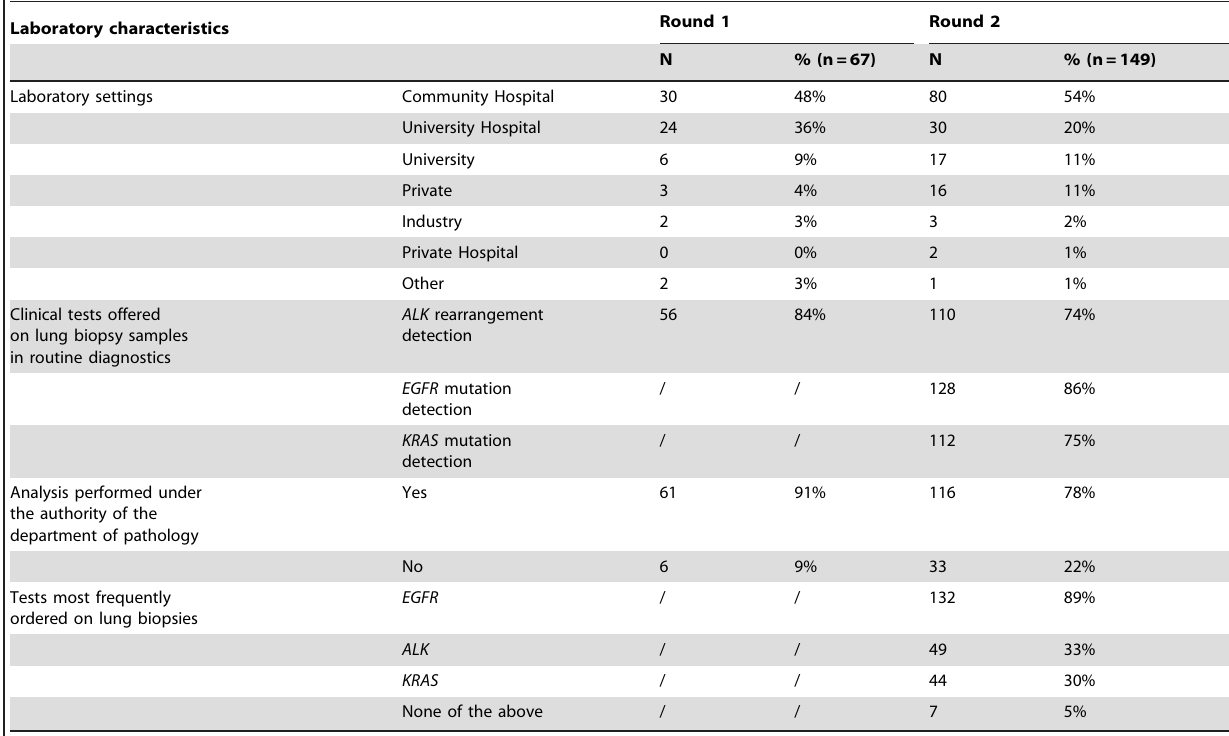
Table 1. Laboratory